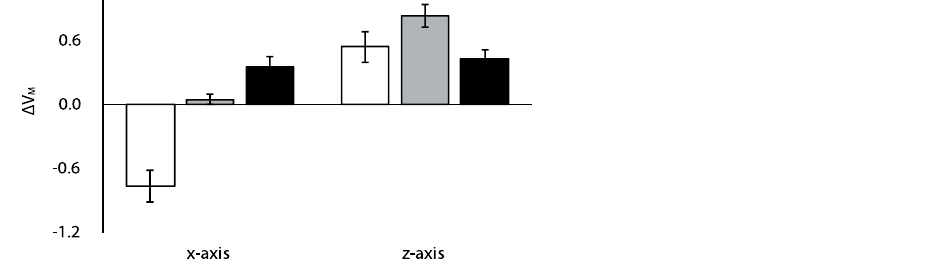
Figure 4. Z-transformed synergy indices related to M TOT stabilization, Δ V M , for the IM (white bars), IMR (gray bars), and IMRL conditions (black bars) at the x - and z -axis. Values are means ± standard errors across the